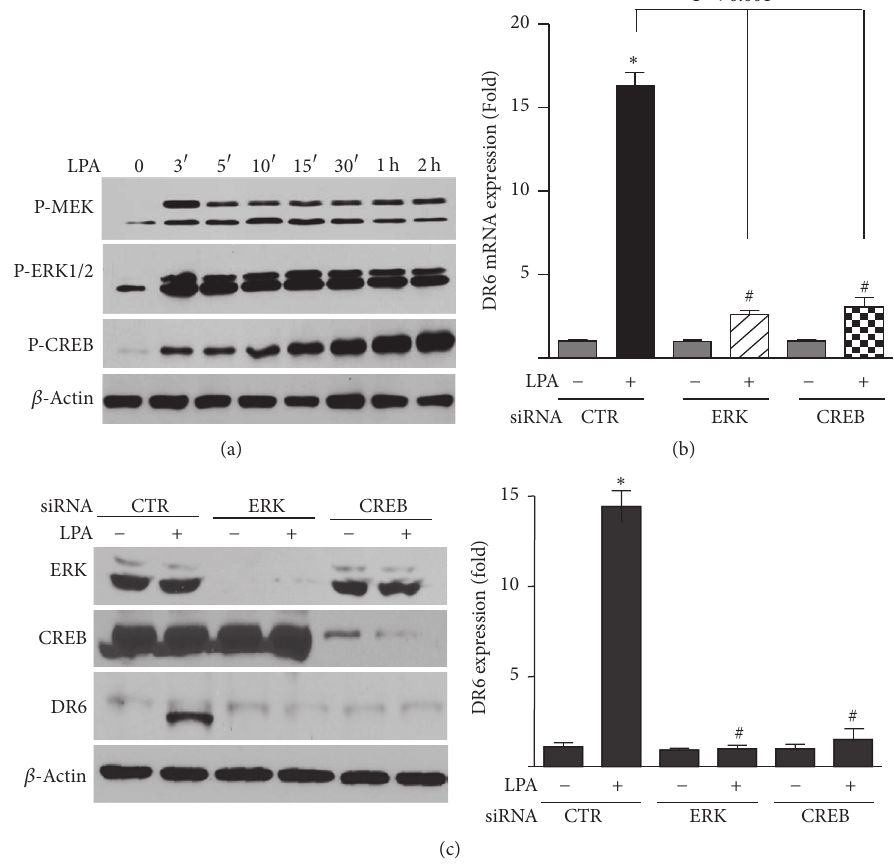
Figure 6: ERK and CREB pathway regulates LPA-induced DR6 expression. (a) HeLa cells were treated with LPA (25 𝜇 M) at various concentrations as indicated. The phosphorylation of MEK, ERK, and CREB was analyzed by Western blotting. The blot is a representative of 3 independent experiments ( 𝑛 = 3 ). (b and c) HeLa cells were treated with LPA in the presence of control siRNA and ERK- or CREB-specific siRNAs. The expressions of DR6 mRNA (b) and protein (c) were measured by q-PCR and Western analysis, respectively. The bar graphs on the right panel of (c) are statistical analysis of DR6 expression. Data presented are mean ± SD from 3 independent experiments, with nontreated controls set as 1. ∗ 𝑃 < 0.001 versus control; # 𝑃 < 0.001 versus LPA/control